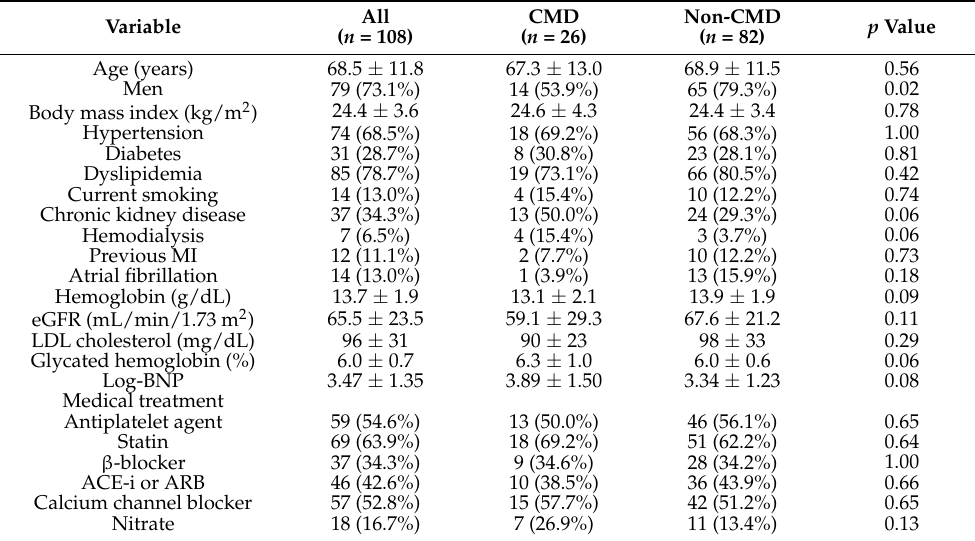
Table 1. Baseline characteristics.